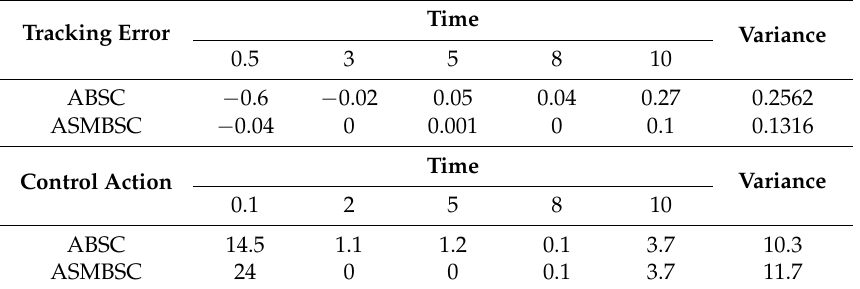
Figure 8. Control action response based on adaptive backstepping and adaptive sliding mode backstepping controllers. Table 2. The performance report of